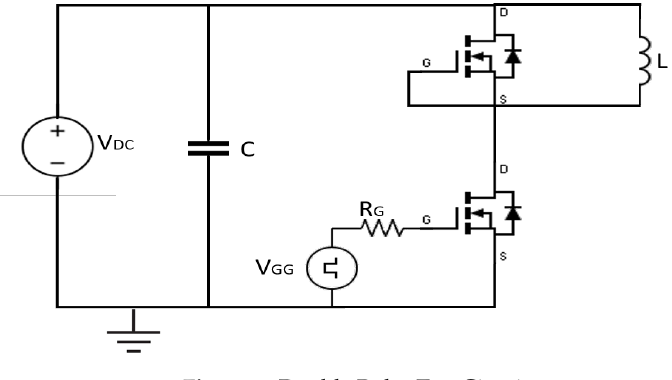
Figure 6. Double Pulse Test